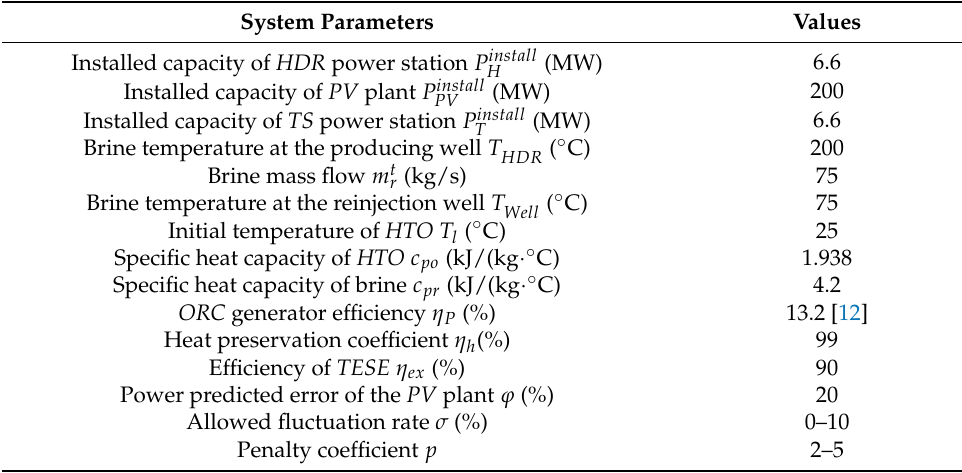
Figure 4. Solar irradiance and TOU price curve.